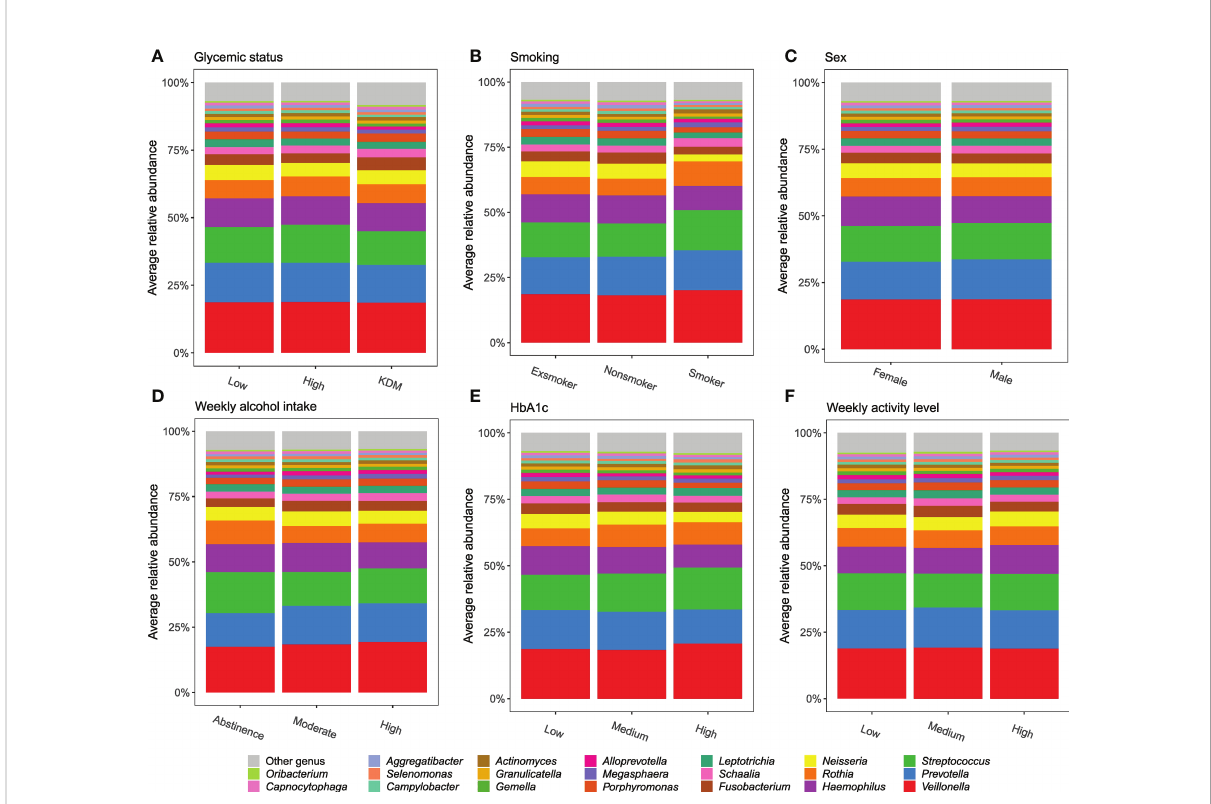
FIGURE 2 Predominant genera. Stacked bar charts of the 20 most abundant genera expressed as mean relative abundance. (A – F) : glycemic status, smoking, sex, weekly alcohol intake, HbA 1c , and weekly activity